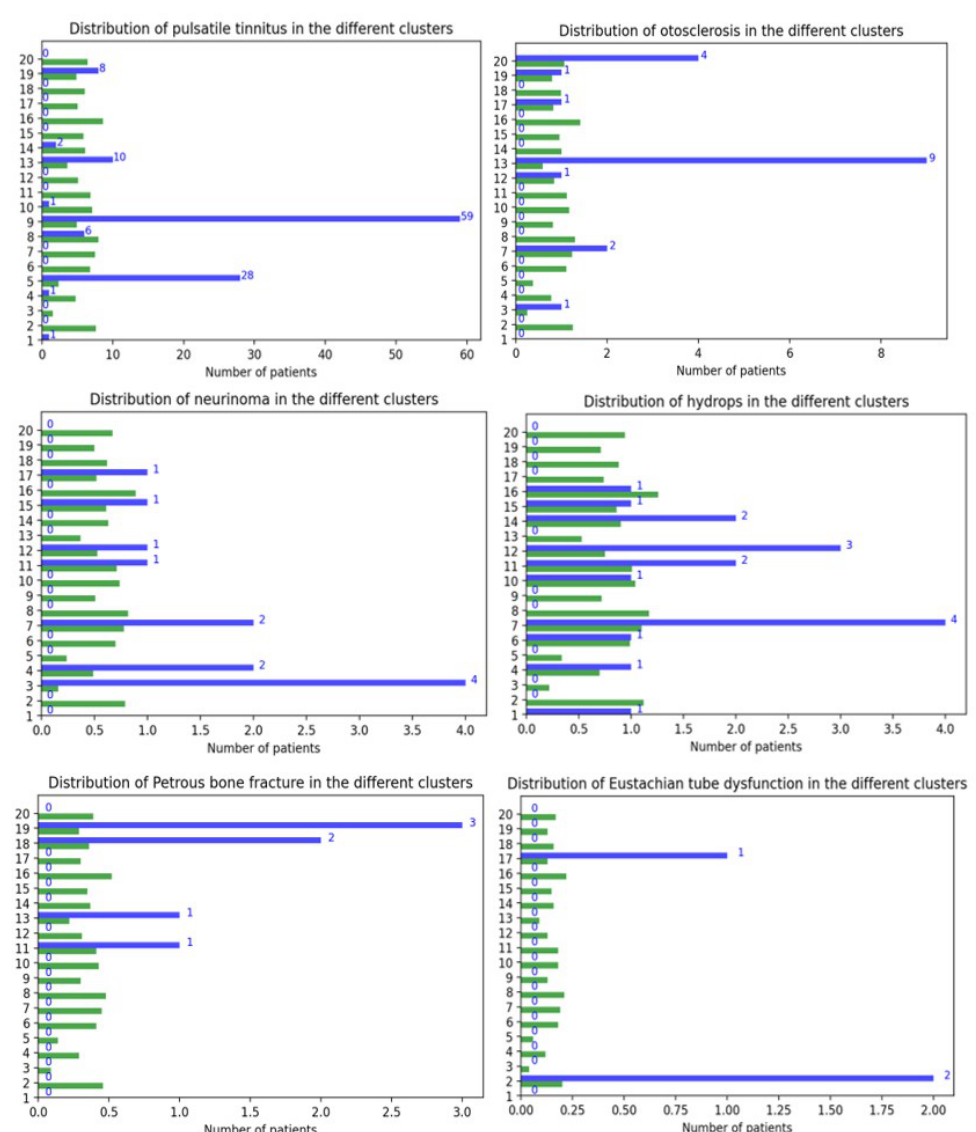
Figure 3. Endotypes’ repartition. The blue bars represent the number of samples of a specific endotype present in the cluster of the number it faces. The green bars represent the number of samples of the same specific endotype that this cluster would contain if the patients of this endotype were randomly assigned to the clusters. For example, on the top left, Cluster 9 contains 59 patients presenting a pulsatile tinnitus, although if the assignment of pulsatile tinnitus patients per cluster was random, we should have expected to have between five and six pulsatile patients in this